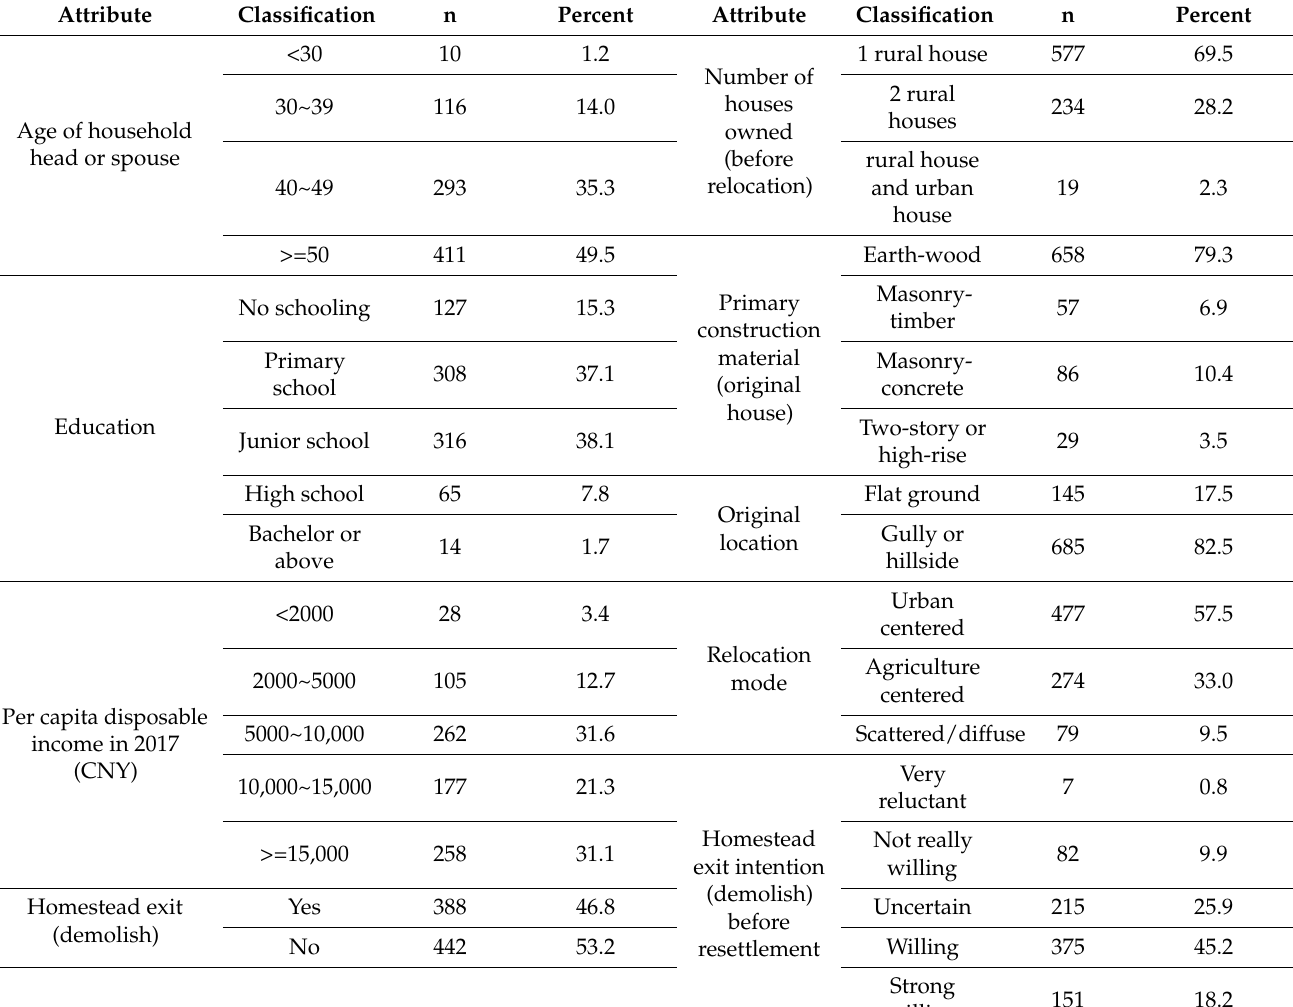
Table 1. Basic characteristics of the sample of relocated rural households (n =